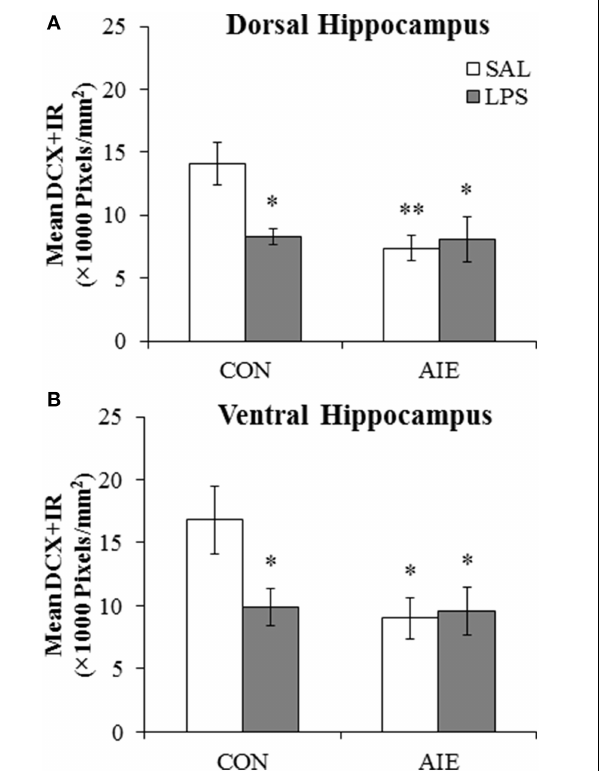
FIGURE 5 | Exposure to lipopolysaccharide (LPS) mimics the loss of doublecortin-immunoreactive (DCX + IR) cells associated with adolescent intermittent ethanol (AIE) exposure. (A) Pixel density quantification in the dentate gyrus of the dorsal hippocampus of young adult rats (postnatal [P]80) revealed a significant reduction of DCX + IR in AIE- (48 ± 5%), CON + LPS (41 ± 7%), and AIE + LPS-exposed (42